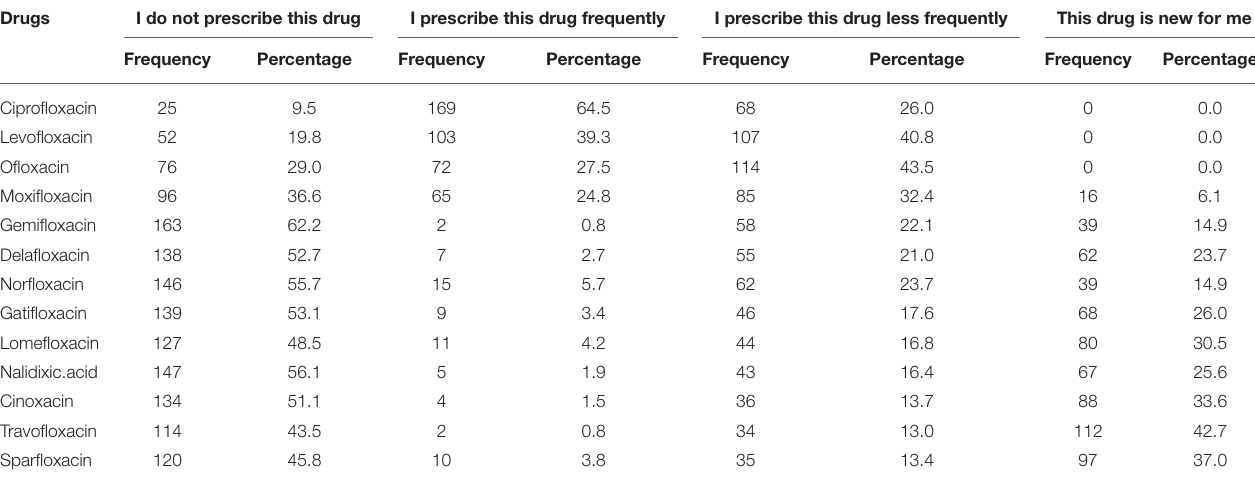
TABLE 2 | Prescribing pattern of fluoroquinolones among prescribers (physicians and dentists), N = 262.